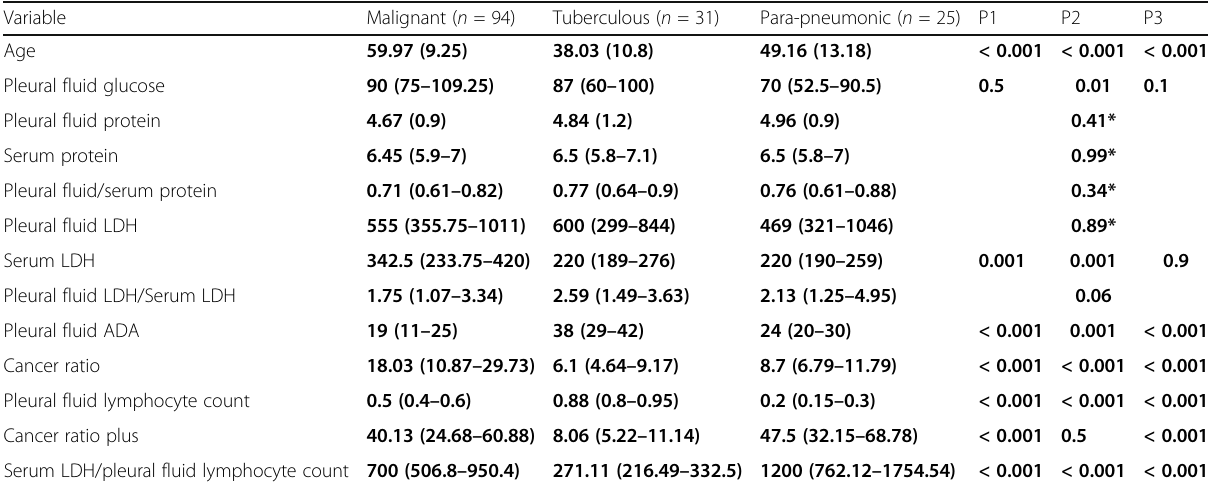
Table 2 Univariate analysis between the different types of pleural effusion